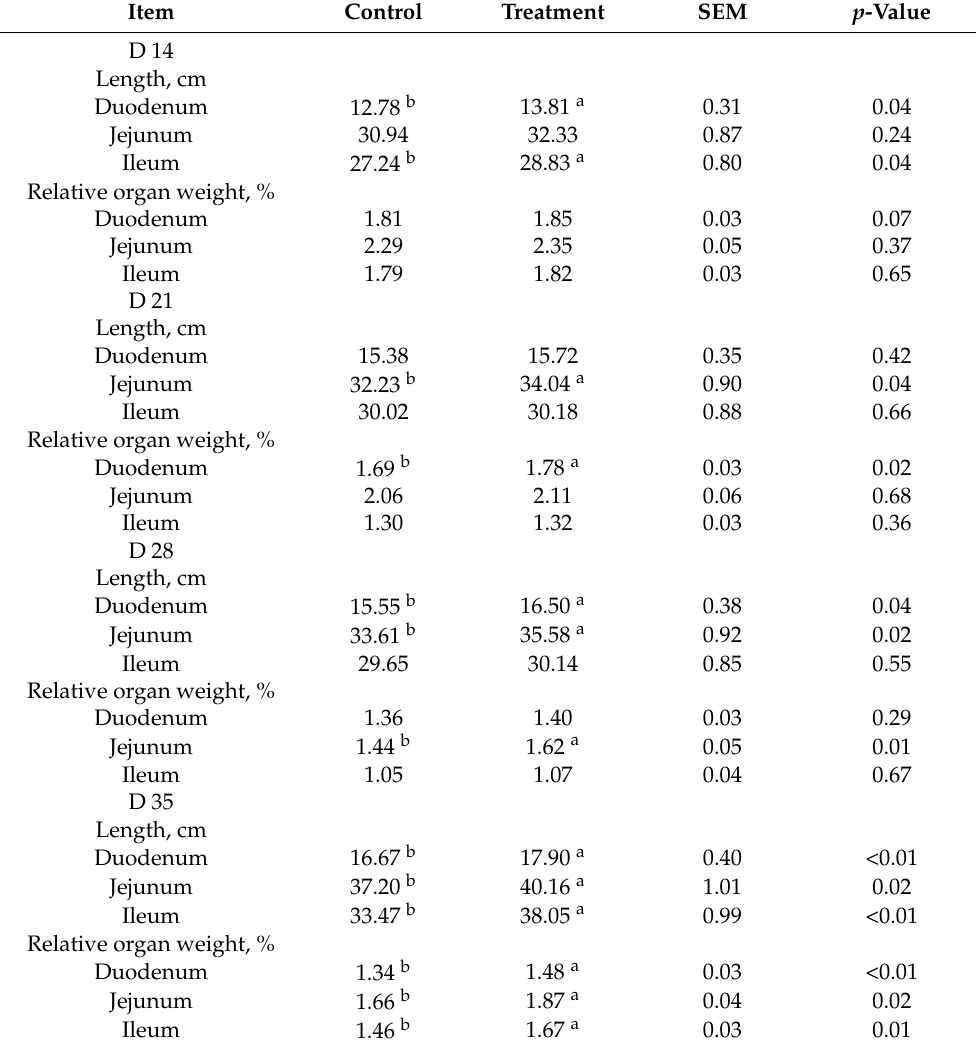
Table 4. Effects of two supplementary doses of vitamin A on length and relative organ weight of intestine in young laying pullets 1